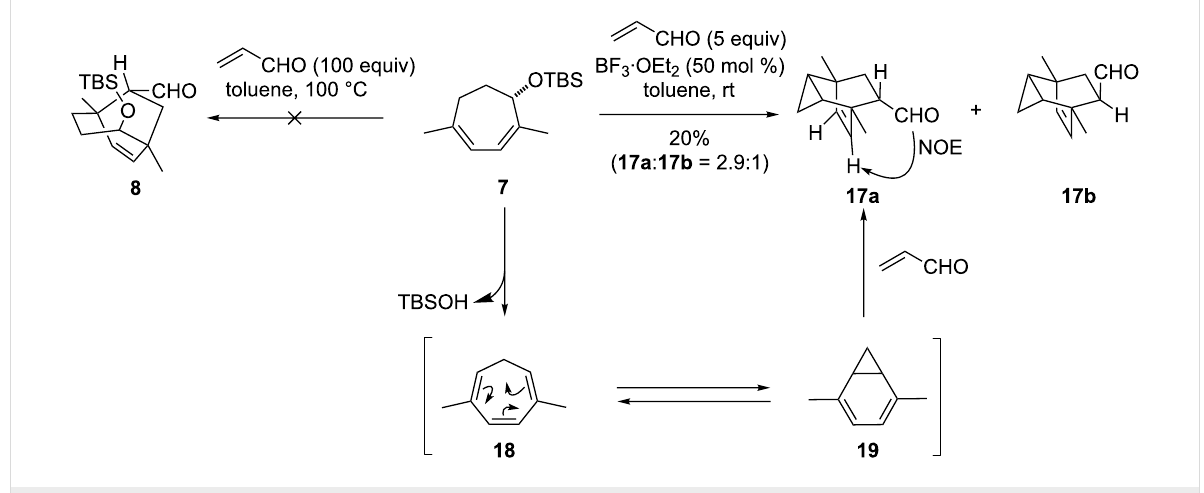
Scheme 3: Generation of 17 through the 6 π -electrocyclic reaction and the Diels–Alder